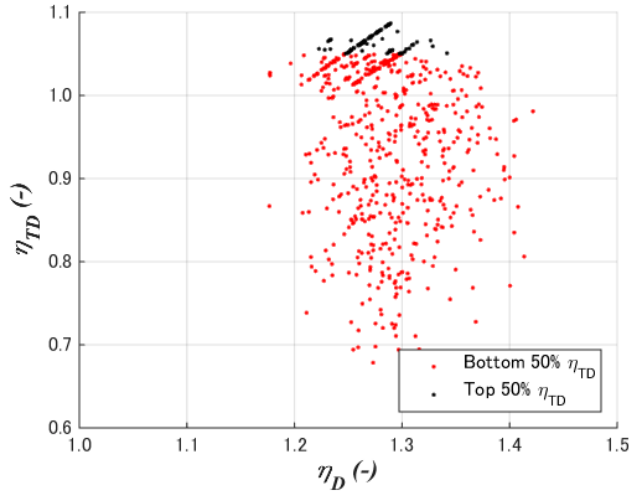
Figure 11. Diffuser total efficiency vs. diffuser efficiency.